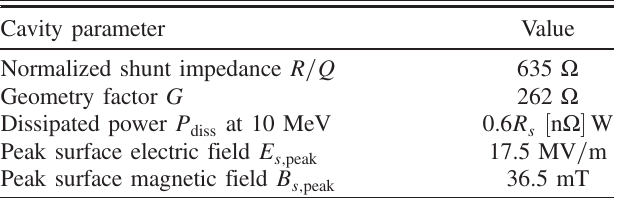
TABLE IV. Parameters of the optimized 650 MHz five-cell SRF